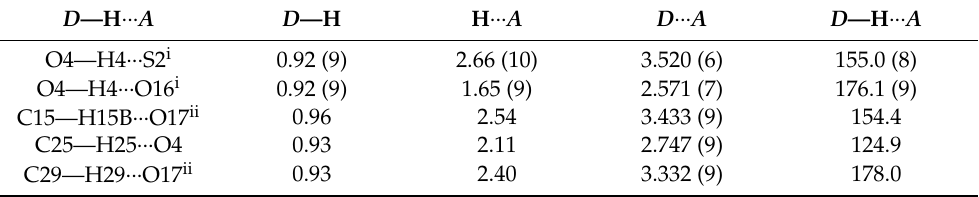
Figure 1. An ORTEP view [42] of the asymmetric unit for 1 showing the TTC unit linked to the p -toluenesulfonate moiety through the H-bond. Displacement ellipsoids are at 50% probability. Table 1. Hydrogen-bond geometry (Å, ◦